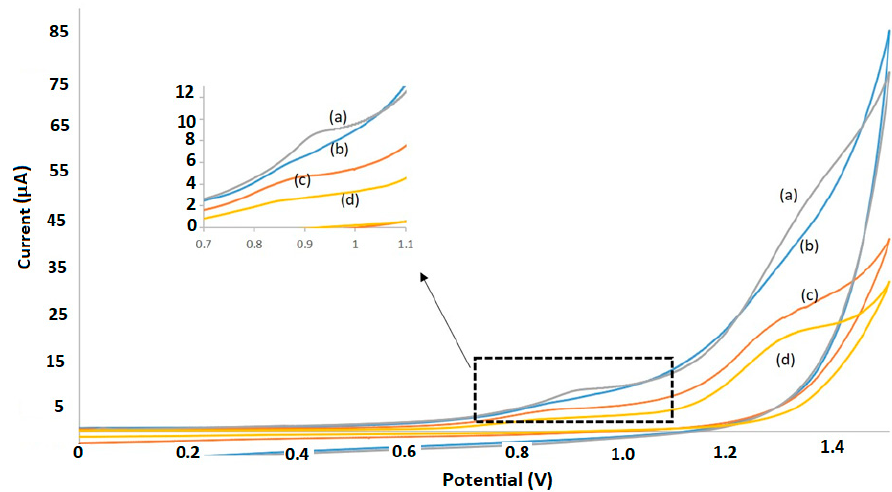
Figure 2. Cyclic voltammograms of different electrodes: ( a ) MIP-SPCE, ( b ) NIP-SPCE, ( c ) MWCNT/TiO 2 -SPCE, and ( d ) non-modified SPCE at 10 mg L − 1 Rhodamine B in 1 M H 3 PO 4 , at scan rate of 50 mV s − 1 .